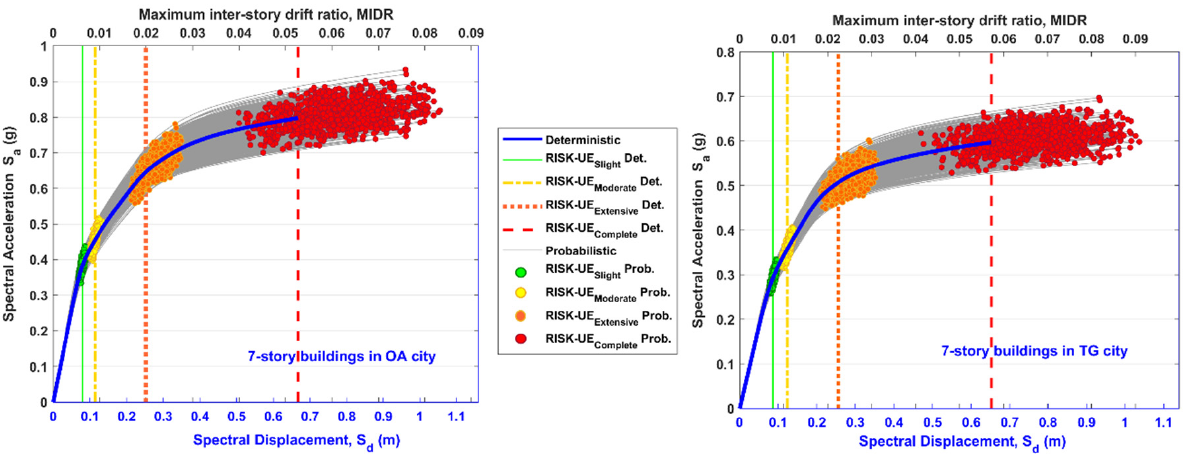
Figure 6. Deterministic and probabilistic capacity spectra of the 7-story buildings in OA and TG cities and their respective DS non-null .